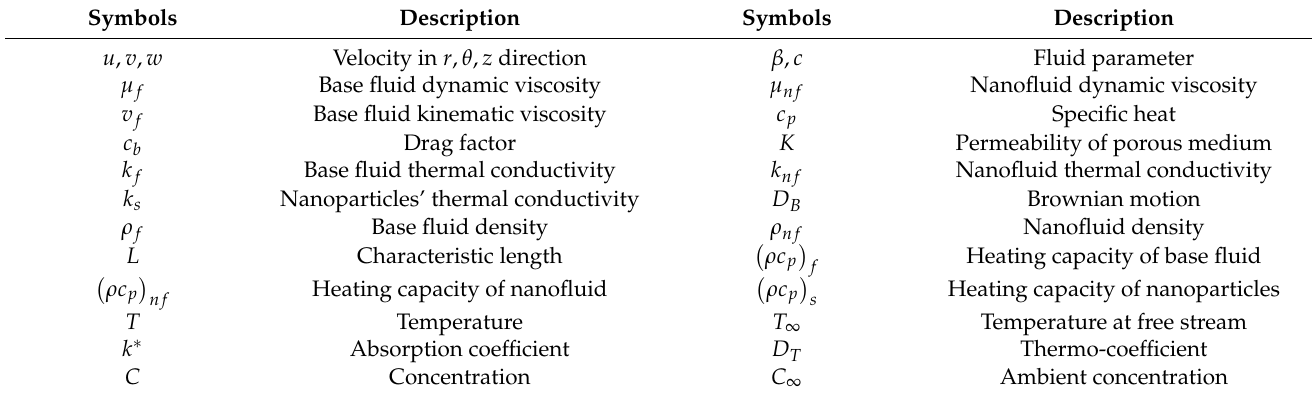
Table 1. A description of the multiple symbols that appear in the governing equations is